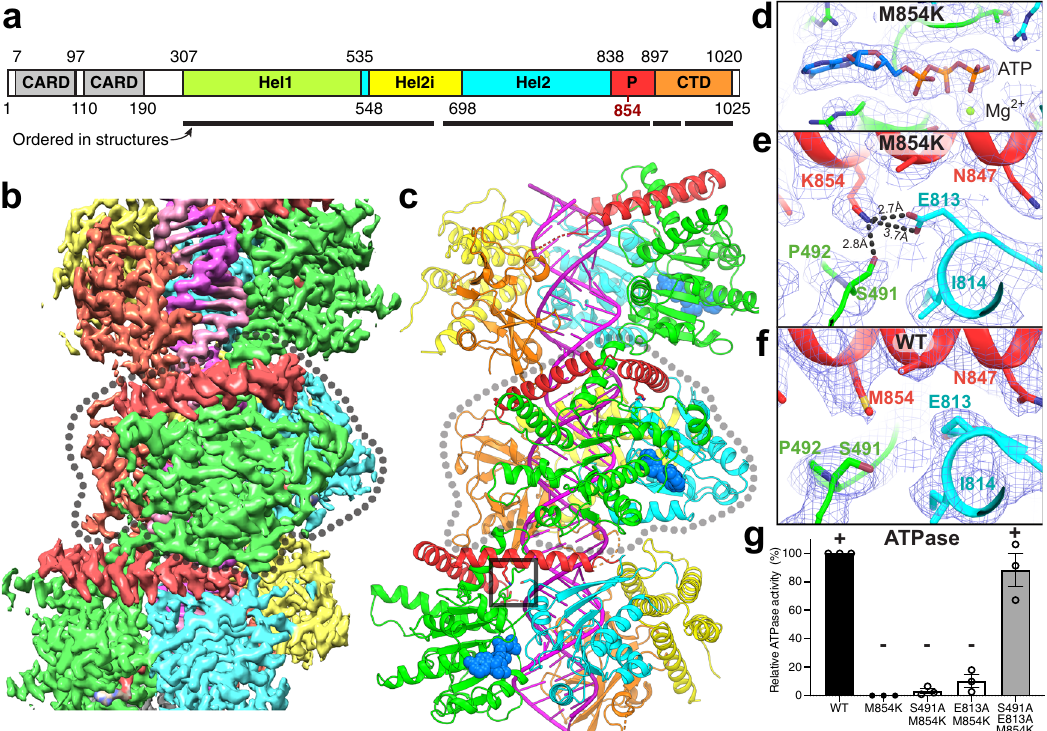
Fig. 3 CryoEM structure of the ATP-bound M854K MDA5-dsRNA fi lament. a Domain architecture of human/mouse MDA5. CARD caspase recruitment domain; Hel1 and Hel2 fi rst and second RecA-like helicase domains; Hel2i, Hel2 insert domain; P pincer domain; CTD C-terminal domain. The same color code is used in panels ( b – e ), Fig. 5a and Supplementary Fig. 4. b 3D density map of the ATP-bound M854K MDA5-dsRNA fi lament at 2.8 Å overall resolution, colored by domain as in ( a ), with RNA in magenta. An MDA5 protomer is outlined in dashed gray. c Overview of the atomic model of the ATP- bound M854K MDA5-dsRNA fi lament. The central protomer of three MDA5 protomers is outlined in light gray. ATP is shown in sphere representation. The region surrounding residue 854 is boxed. d , e Closeups of cryoEM density maps: the bound ATP, d , and the region surrounding residue 854, showing polar contacts formed by Lys854 with residues from the Hel1 and Hel2 domains, ( e ). Polar contacts formed by Lys854 are shown as dashed lines. f Closeup of the region surrounding residue 854 in the previously reported structure of the WT MDA5-dsRNA fi lament with AMPPNP bound 14 . g Relative ATPase activities of S491A/M854K, E813A/M854K, and S491A/E813A/M854K mutants, normalized to WT (100%) and M854K (0%). Error bars represent SEM between measurements, centered on the mean. ( n = 3 independent samples; t = 15 min). ATPase assays were repeated in independent experiments three times with similar results. Source data are provided as a Source Data fi